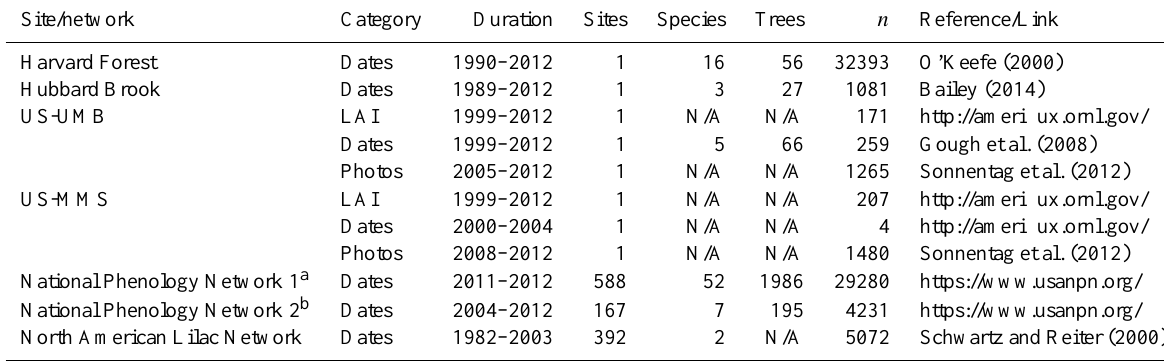
Table 4. Ground phenology measurements of deciduous trees used to validate the